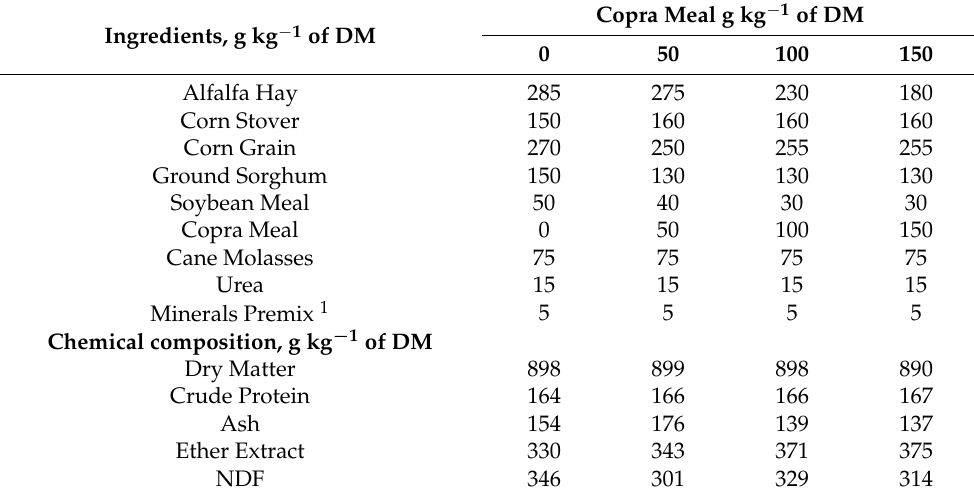
Table 1. Ingredients and chemical composition of the experimental diets. Ingredients, g kg − 1 of